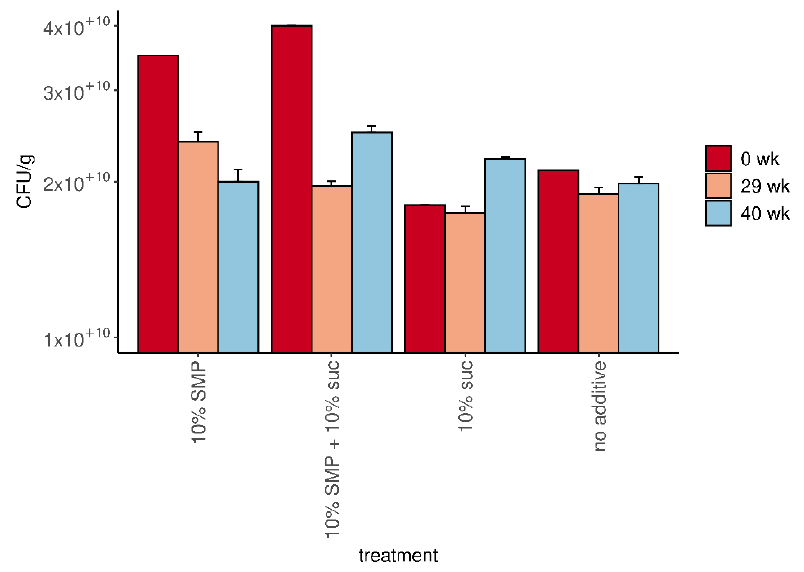
Figure 2. Skim milk powder (SMP) and sucrose do not improve long-term survival of freeze-dried M. pulcherrima cells. Freeze-dried M. pulcherrima cells were stored at 4 °C and the CFU was determined immediately after freeze-drying and after 7 and 9 months, respectively. Error bars represent the standard error of four replicates. No significant differences were observed.